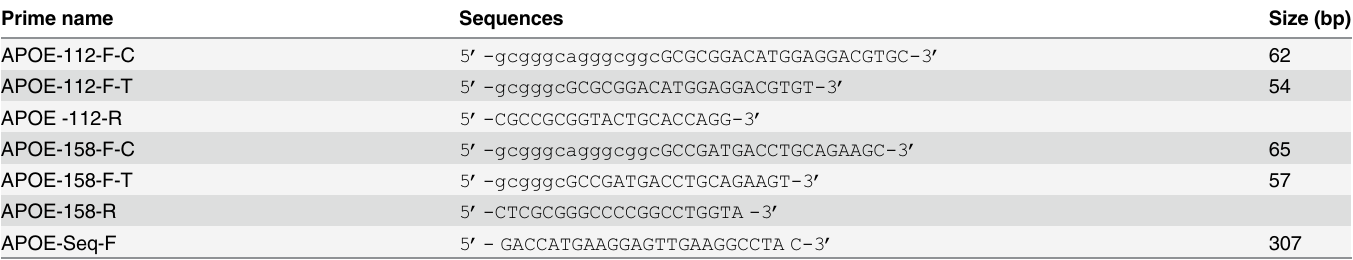
Table 1. Sequences of primers, annealing temperatures and the sizes of PCR product in this